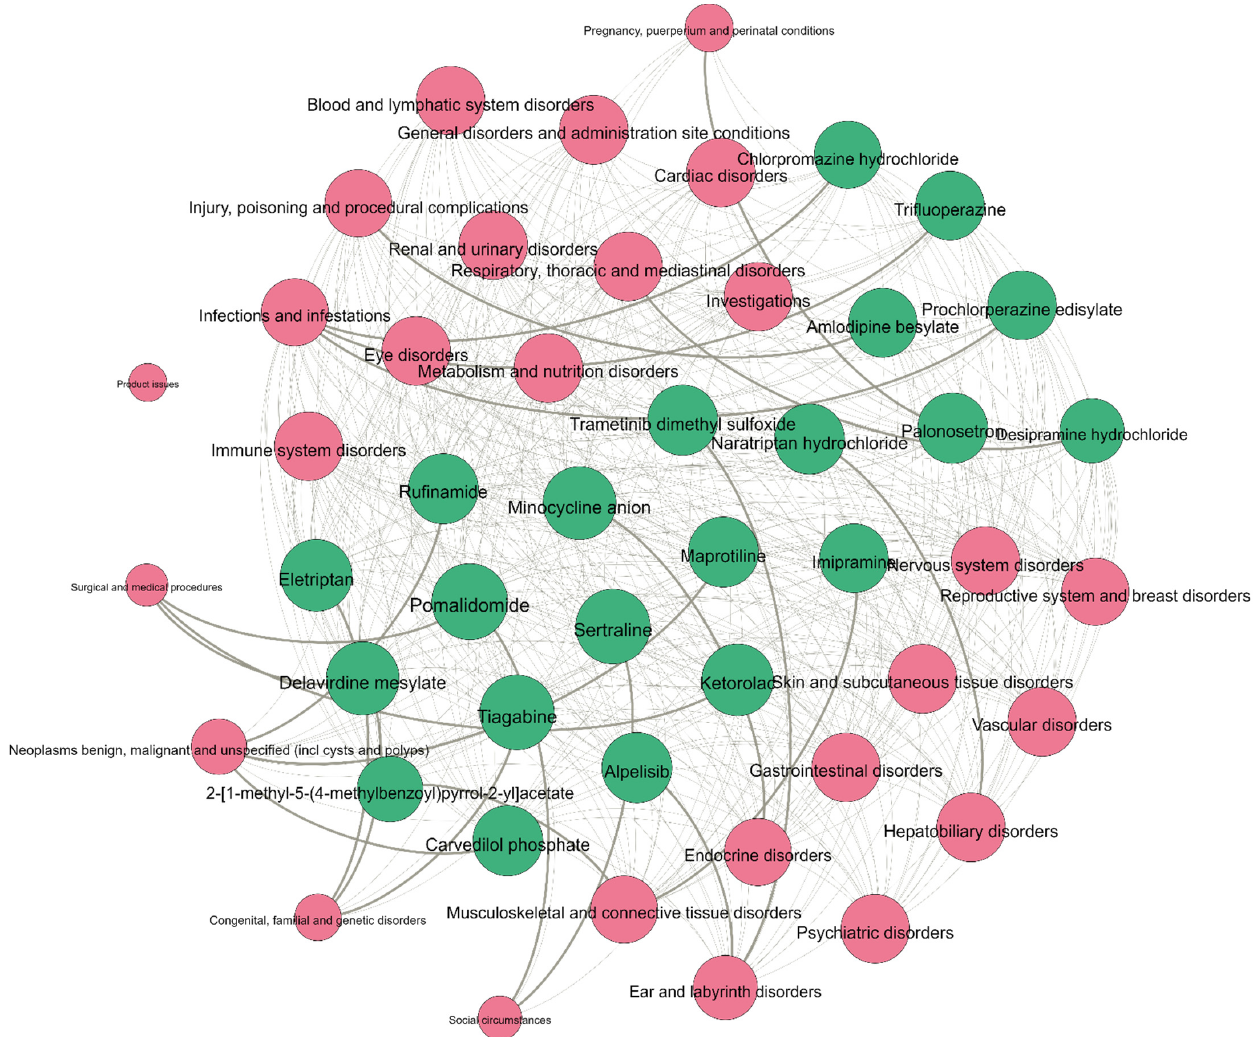
Figure 3. Drug and ADR association graph, represents the drug node, while represents the adverse reaction node; the more drugs connected to the ADR, the larger the node of the ADR; the line connecting the drug node and the ADR node indicates that the drug has these adverse reactions, and the thickened line indicates the potential adverse reactions of the drug. Table 3. Potential adverse-drug-reactions.